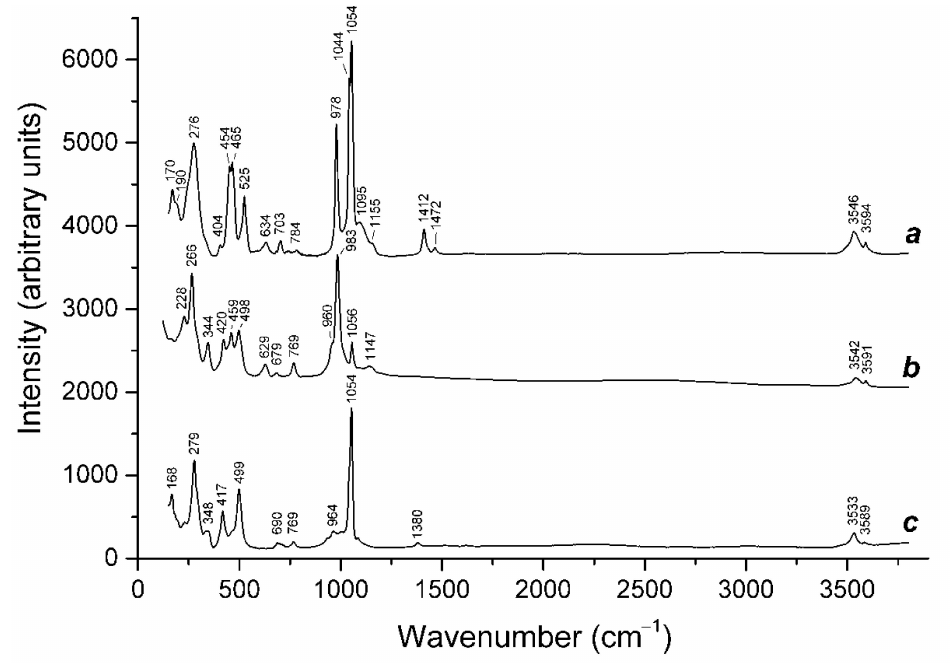
Figure 8. Raman spectra of ( a ) S- and P-bearing cancrisilite (Sample 3), ( b ) CO 3 2 − -bearing vishnevite (Sample 2) and ( c ) cancrinite (Sample